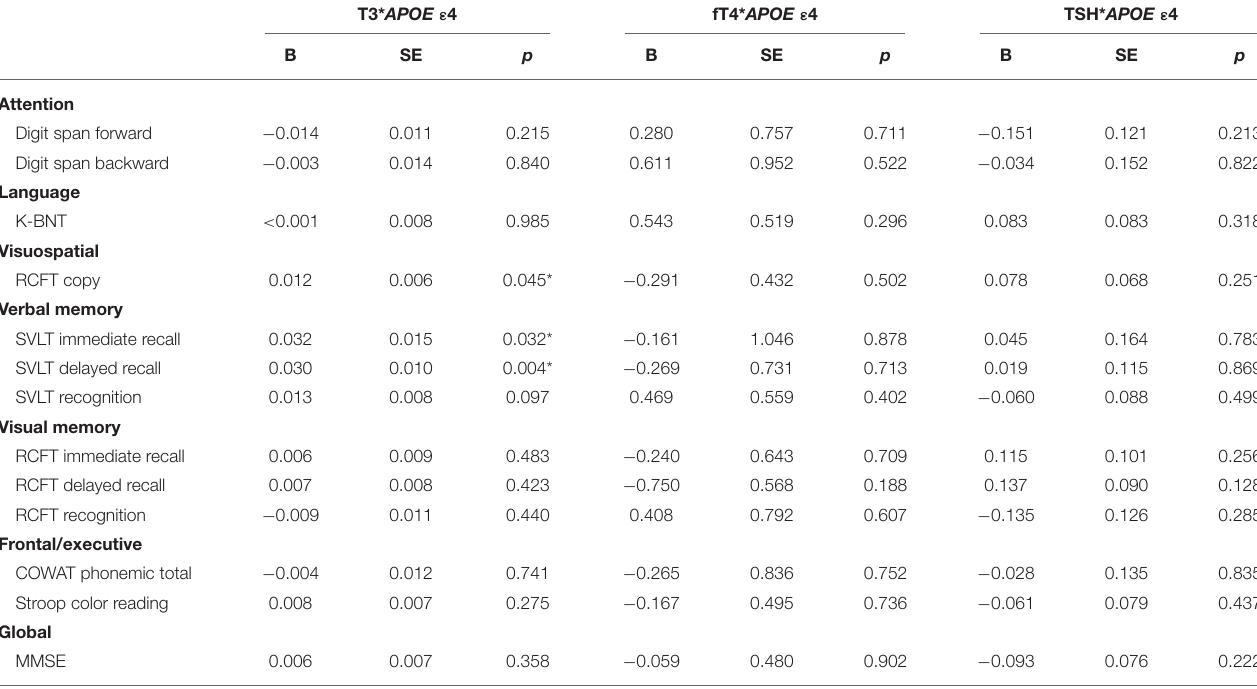
Multiple linear regression was performed using sex, vascular risk factors (hypertension, diabetes mellitus, hyperlipidemia, cardiovascular disease, and history of stroke), APOE ε 4 status, thyroid hormones including TSH, and an interaction term (thyroid hormones including TSH by APOE ε 4 status) as independent variables. Age- and education-specific Z-scores were used asdependent variables. * Indicates p < 0.05.APOE,apolipoproteinE;SCD,subjectivecognitivedecline; T3,triiodothyronine; fT4,freethyroxine; TSH,thyroid-stimulating hormone; B, β value; SE, standard error; K-BNT, Korean version of the boston naming test; RCFT, Rey-osterrieth complex figure test; SVLT, Seoul verbal learning test; COWAT, Controlled oral word association test; MMSE, Mini-mental state